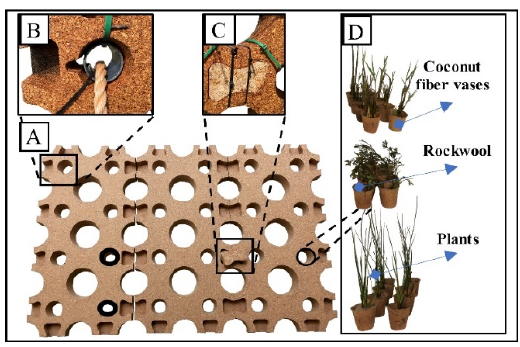
Figure 2. Floating wetland island design: ( A ) Floating platform modules; ( B ) detail of the cable responsible for the anchoring system; ( C ) joints between modules; ( D ) plants setup.